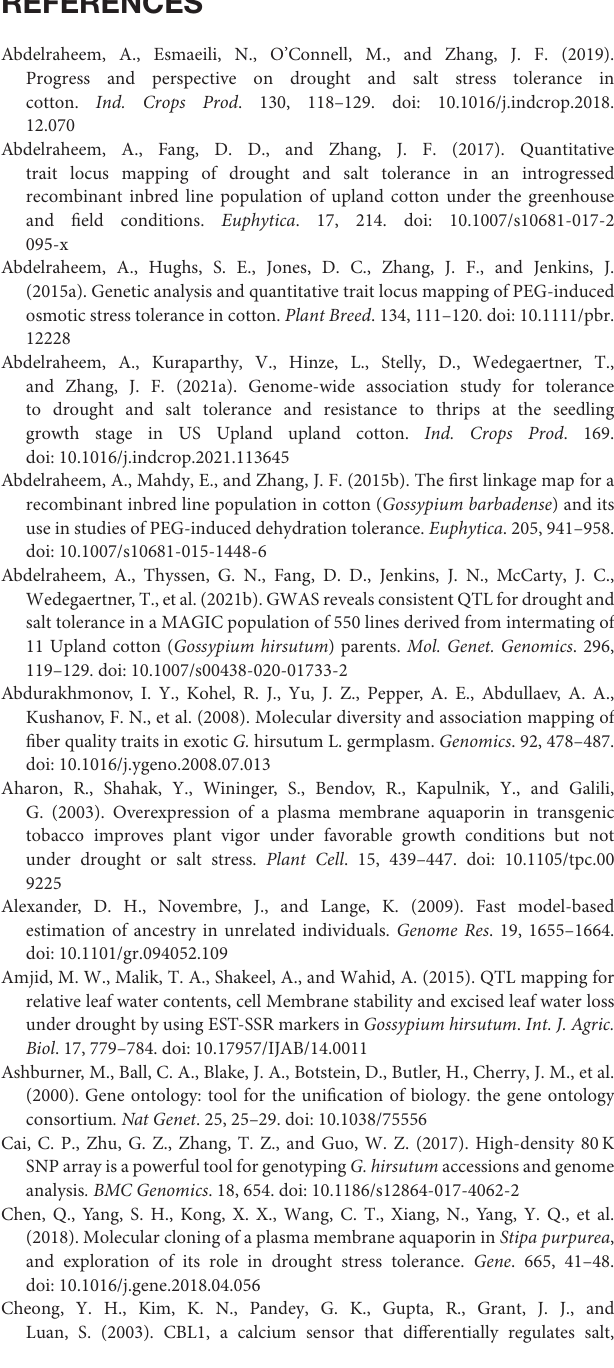
Supplementary Table 2 | Data acquisition for eight traits in four environments. “Y” represented that data were collected; “-“ indicated that data were missing. Supplementary Table 3 | SNPs significantly associated with drought-tolerance that were detected using five models with GAPIT software. E 1 , E 2 , E 3 , and E 4 indicate the four environments 2015–2016 Damao in the field, 2015–2016 Damao in the greenhouse, 2016–2017 Yacheng in the greenhouse, and 2016–2017 Baogang in the field, respectively. CHL, chlorophyll content; LA, leaf area; PH,